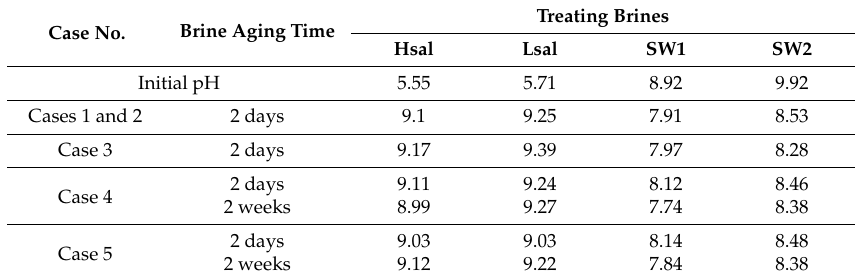
Table 8. Initial and final pH values (after treatment of calcite surfaces with different brines) of the treating brines.